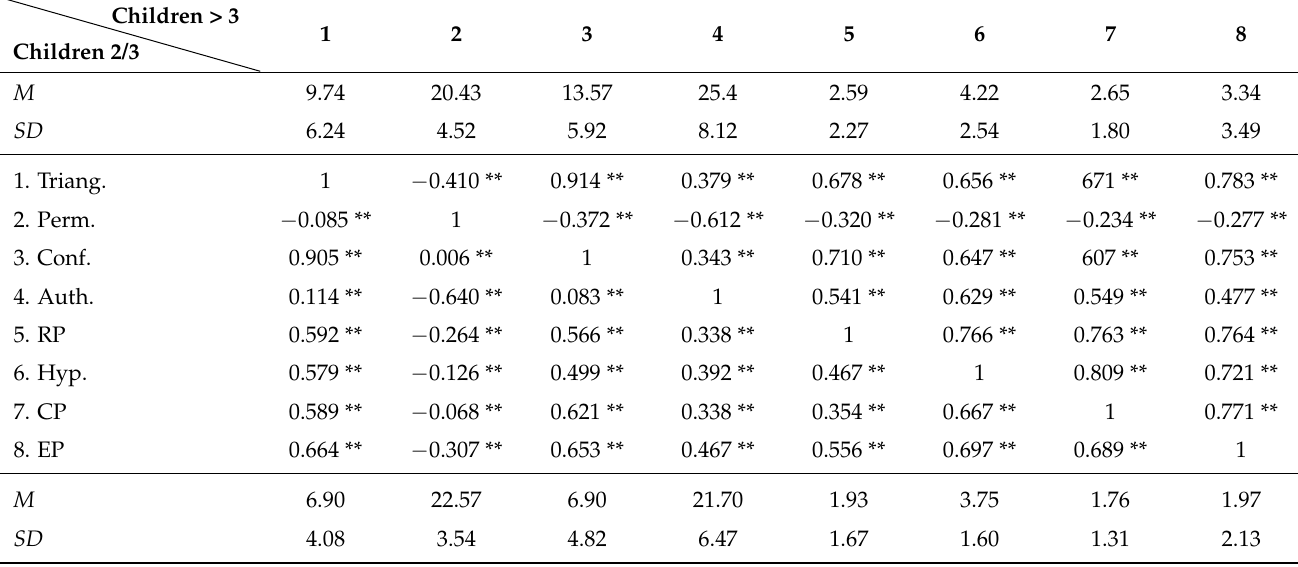
Table 1. Descriptive statistics and correlation matrix of the variables according to children’s age (child 2/3 n = 93; child > 3 n =